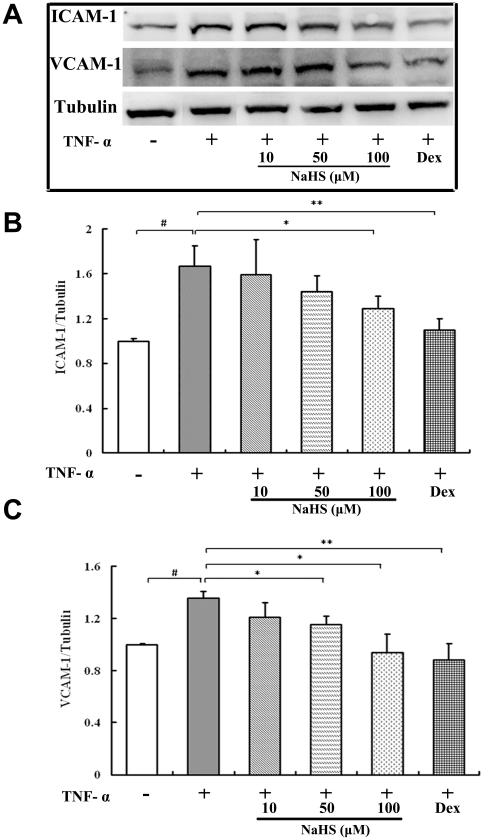
NaHS inhibited TNF-α-induced expression of ICAM-1 and VCAM-1.HUVEC were pre-treated with NaHS (50–100 µM) or Dex (10 µM) for 30 min and then stimulated with TNF-α (10 ng/ml) for 6 h. (A) Representative Western blot showed the expression of ICAM-1 and VCAM-1. Tubulin was used as loading control. Bar graphs represent the quantitative difference in expression of ICAM-1 (B) and VCAM-1 (C), respectively, in arbitrary units. #
P<0.05 compared with unstimulated cells, *P<0.05, **P<0.01 compared with TNF-α-stimulated cells. Data are the mean ± S.E.M of results from at least three independent experiments, each performed in duplicate.